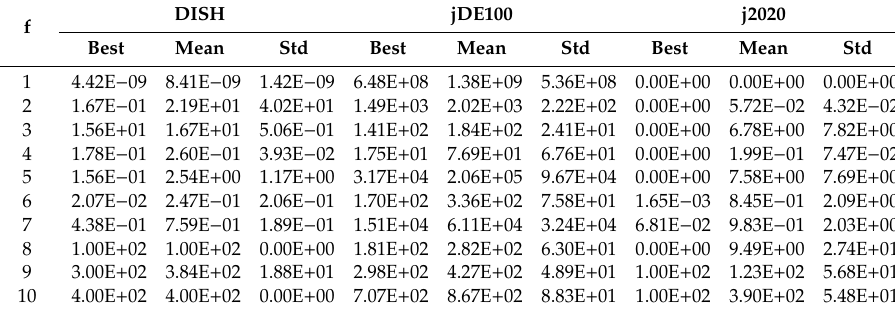
Table 21. DISH and jDE100 on CEC2020 in 15 D .